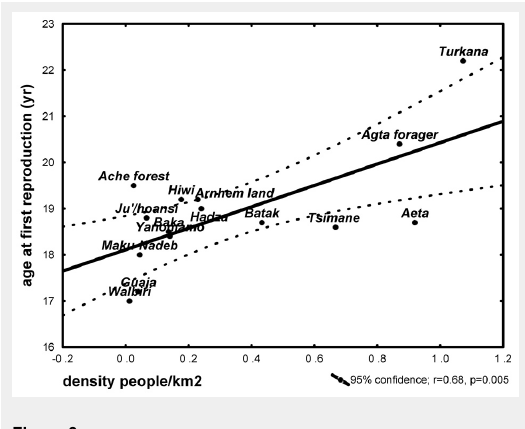
The regression line and the 95% confidence limits for the age of first reproduction as a function of density in traditional societies